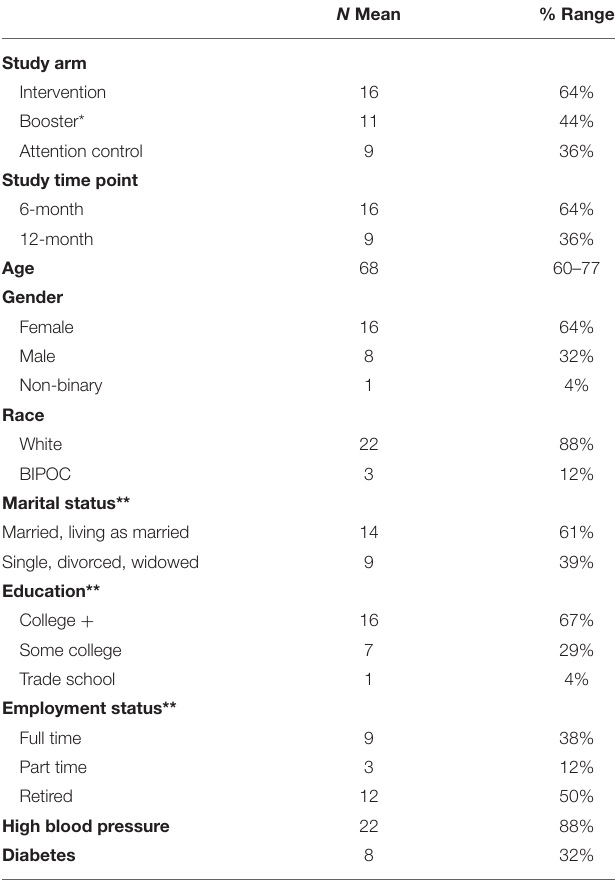
TABLE 1 | Baseline demographic characteristics of interview